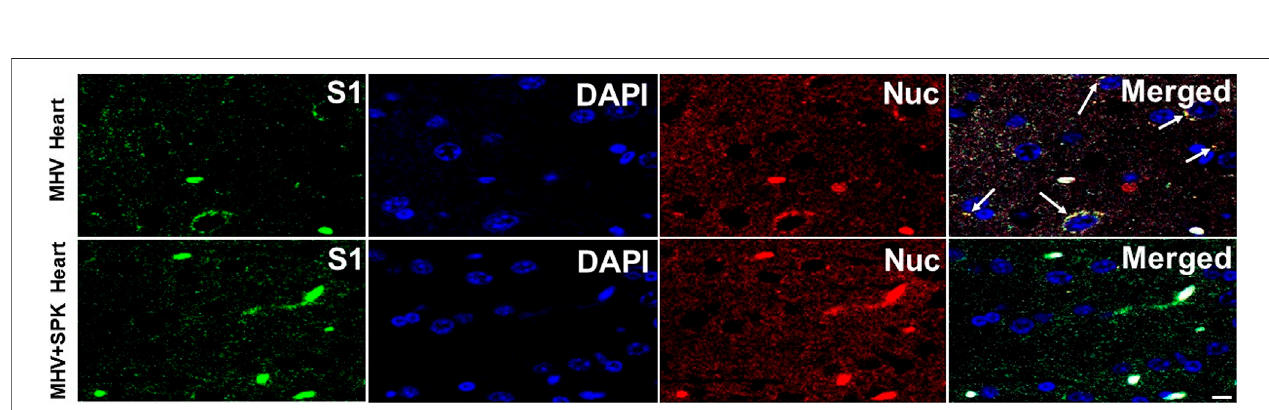
FIGURE9| ThepresenceofMHV-1viruswithandwithoutSPKtreatmentinheart.Thelongarrowsindicatethepresenceofviralparticles(S1andNucleocapsid)in the hearts of MHV-1 infected mice. The viral particles are absent in the SPK treated group. n = 4. Scale bar = 30 μ m.